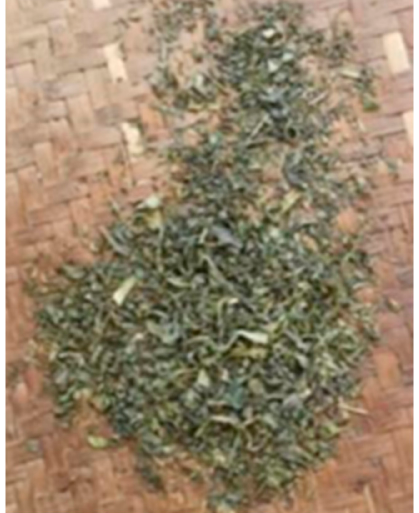
Figure 14. Main impurities in pan-fried green tea.